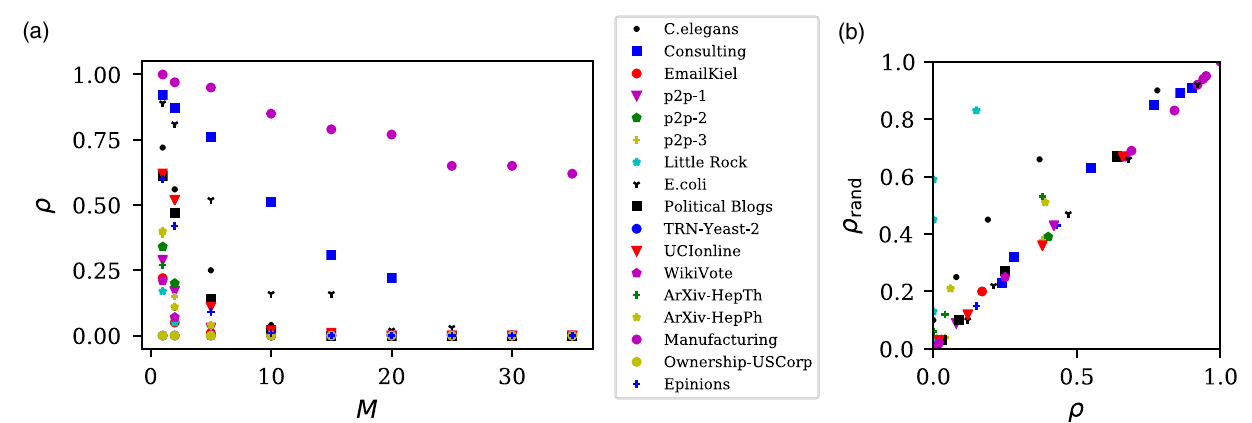
FIG. 9. Structural invertibility of real networks. (a) The probability of invertibility under the random scheme. For each network in Table I, the disjoint sets of M ¼ P input and output nodes are obtained by uniform random sampling (scenario SC I). This sampling is repeated 100 times for each M , and the fraction ρ of structural invertible graphs is estimated. (b) Comparison of ρ from (a) to the probability of invertibility after a degree-preserving randomization ( ρ ). Note that some of the symbols are exactly masking each rand other. In this randomization, the in and out degree of each node is preserved, and the nodes linked to each other are randomly selected